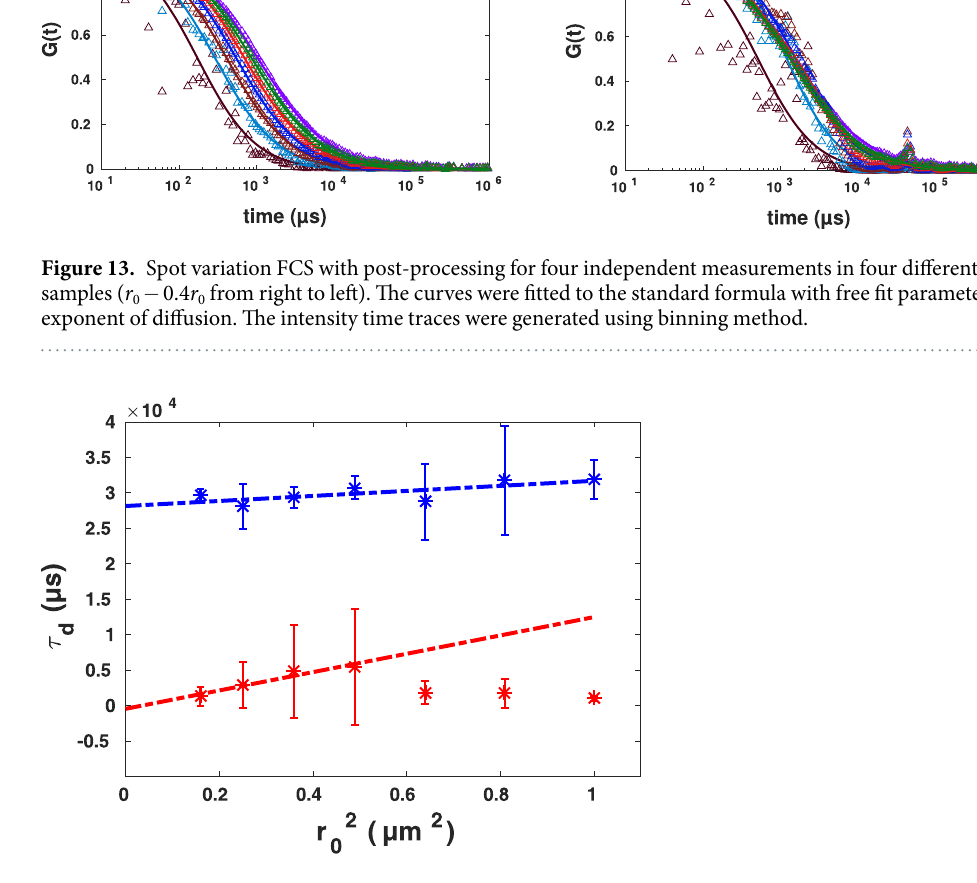
Figure 14. Diffusion time of AlexaFluor647-labeled streptavidin in DMSO:glycerol solution for slow component (blue) and fast component (red) versus spot size, together with corresponding linear fits 02 with Pearson r 2 = 0.45 and τ = − r 12, 941 474 02 with Pearson r 2 = 0.91. Standard τ = + r 3, 555 28, 133 d d deviations were calculated from eight measurements in four sample